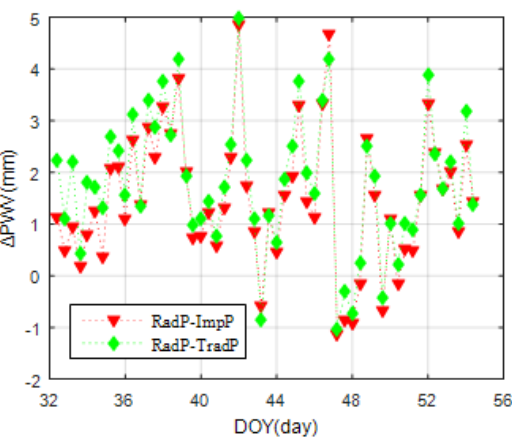
Figure 5. Comparisons of PWV obtained from tomography and radiosonde product in February 2014. “RadP-ImpP” rep- resents the difference of radiosonde-derived and optimized tomography-derived PWV. “RadP-TradP” represents the difference of radiosonde-derived and traditional tomography-derived PWV. Table 4. The statistical results between tomography-derived and radiosonde-derived water vapor density above 3.75km and below 3.75km, respectively (gm − 3 ) . “RD” represents the relative differ- ences. Height Below 3.75km Above 3.75km Bias RD Bias RD Mean